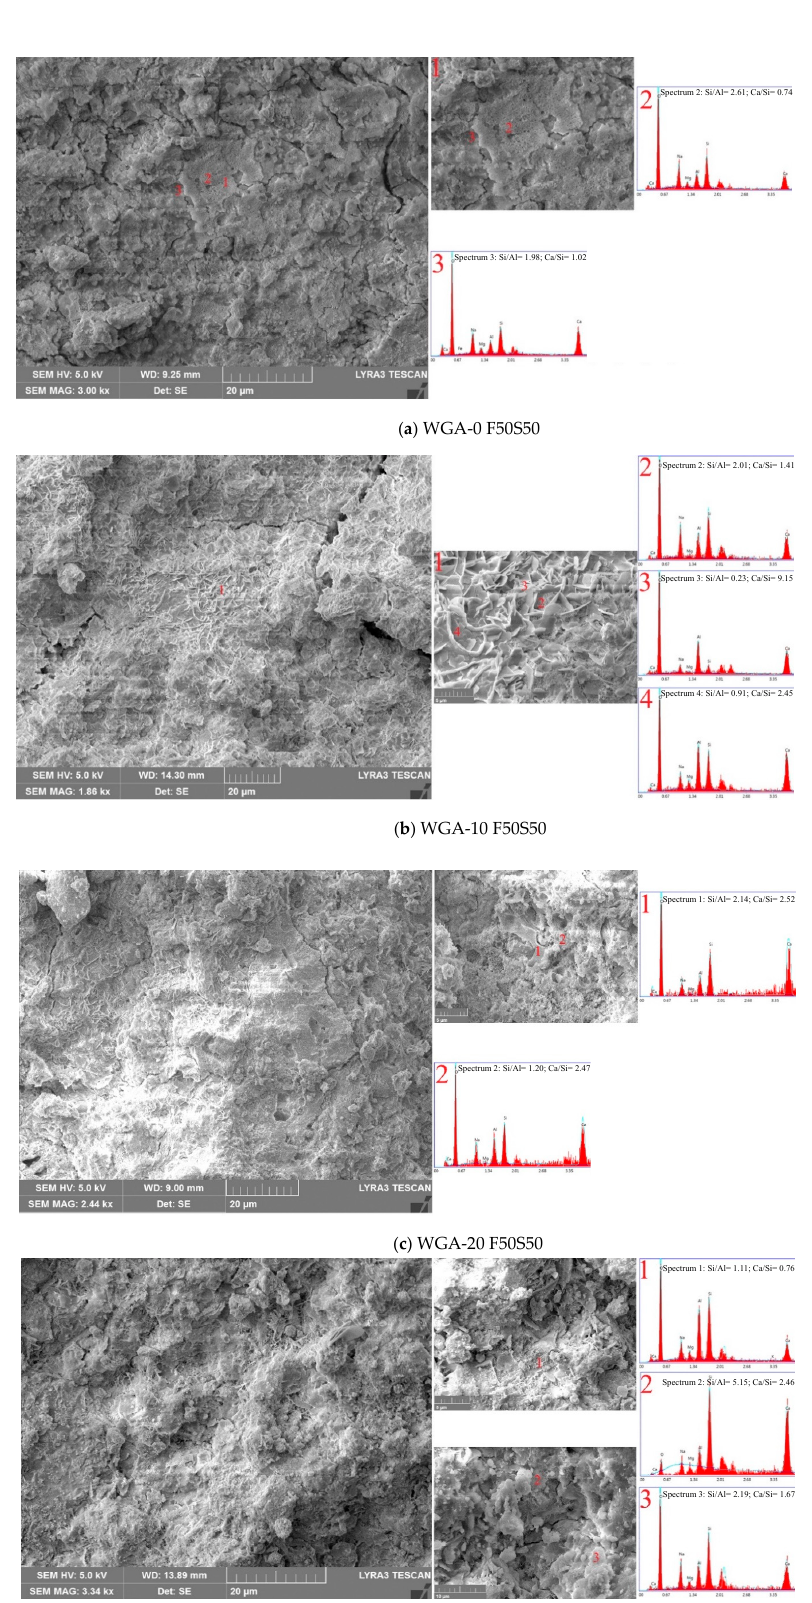
Figure 12. SEM Micrographs and EDX spectra of sample F50S50 activated in ( a ) WGA-0, ( b ) WGA-10, ( c ) WGA-20 and ( d ) WGA-30 solution.